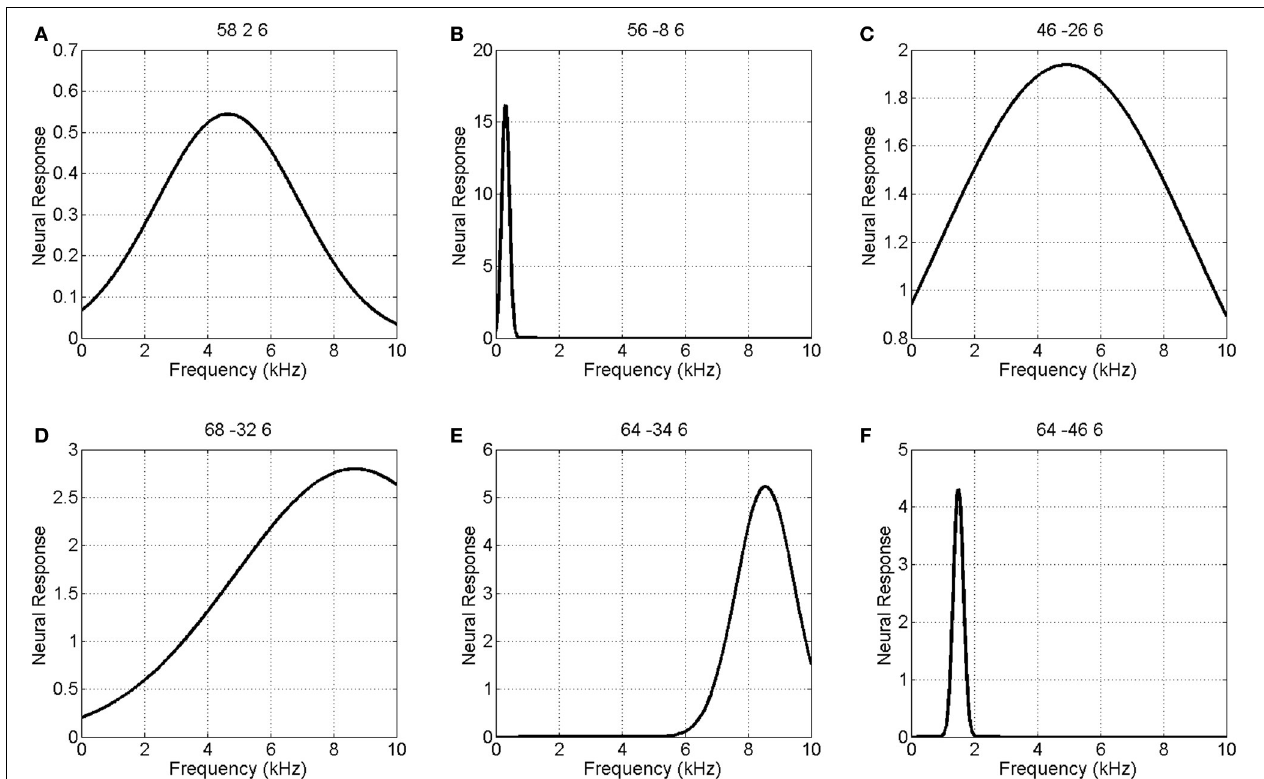
FIGURE 6 | Estimated Gaussian neural response functions at six selected voxels (voxel indices denote MNI coordinates in mm). The labeling (A – F) refers to positions shown in the top left panel of Figure 5